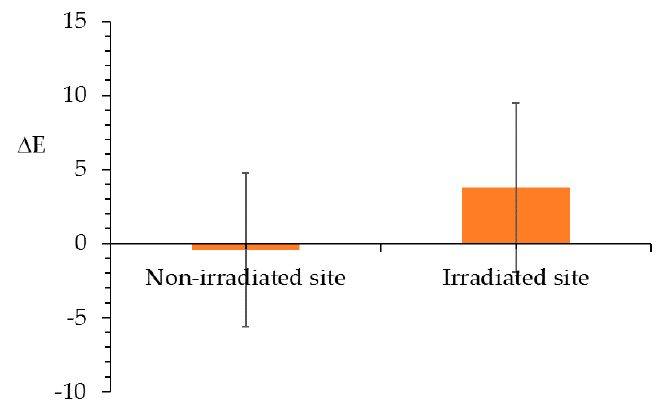
Figure 2. Changes in erythema at the UVA-irradiated site and non-irradiated site. The results are expressed Δ E, which was calculated by subtracting the value of Erythema Index (E) immediately before irradiation from that a day later, as the mean ± standard deviation of six subjects.